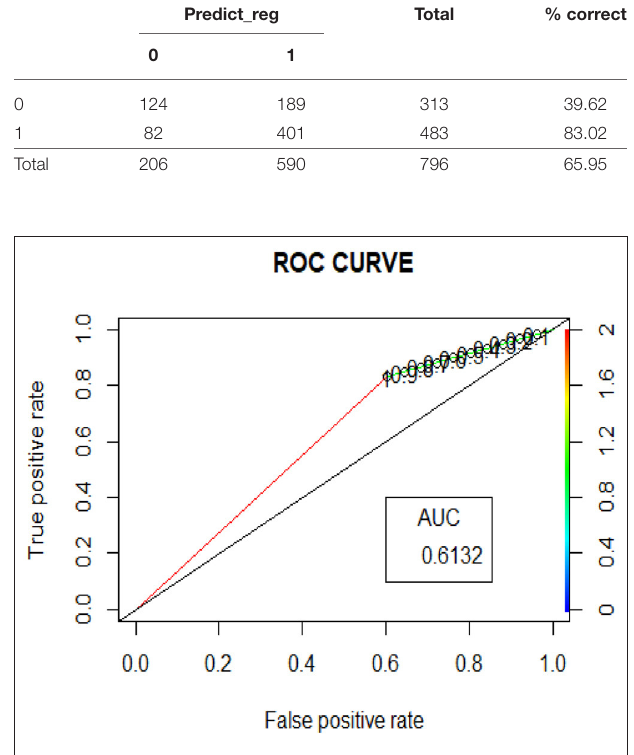
FIGURE 4 | ROC curve in logistic regression.